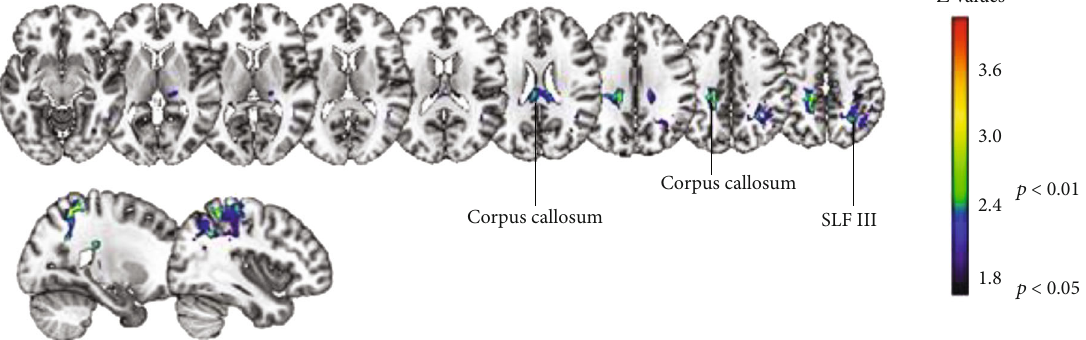
Figure 4: Signi fi cant brain-behavior associations observed between F-M UE recovery index and white-matter